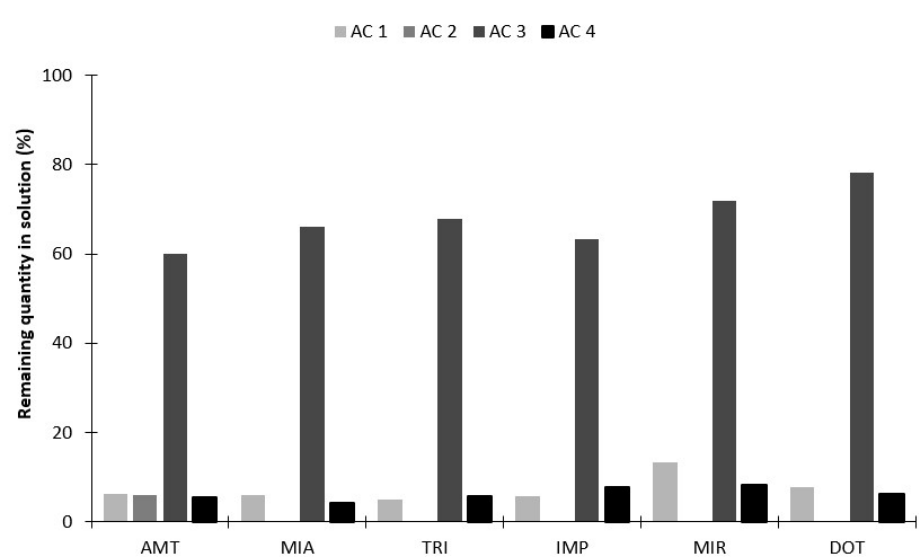
Figure 2. Remaining TCAs present in the aqueous matrix after the microextraction stage using the four different ACs prepared from biomaterials waste.